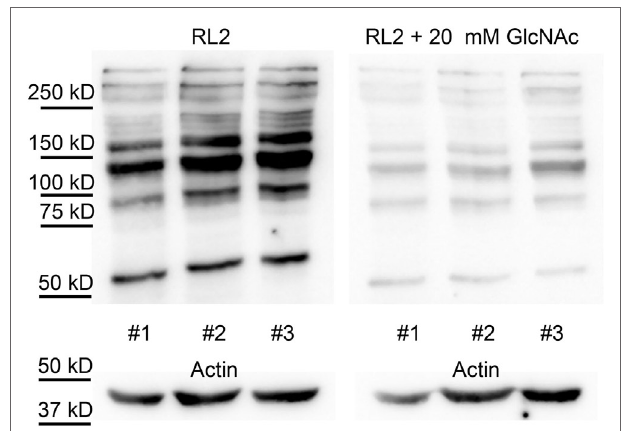
FigUre 4 | RL2 specifically binds to O-GlcNAc proteins. Western blot analysis using RL2 antibody and anti-actin antibody shows samples of white blood cells protein extracts from three individuals, collected at random dates. Membranes were incubated with RL2 antibody (left panel) or RL2 antibody and 20 mM of N -acetylglucosamine (right panel). Immunoblots with anti-actin antibody was used as loading control. FigUre 3 | O-GlcNAc levels elevate in leukocytes following exercise.